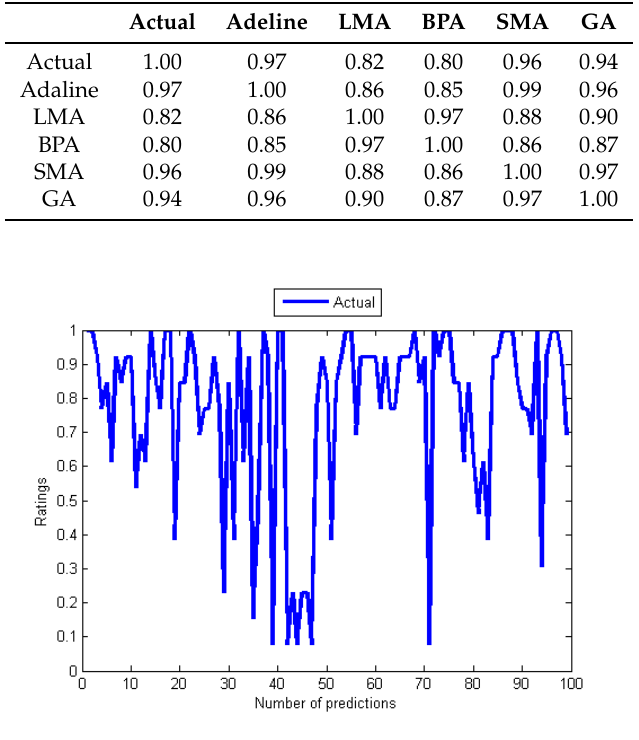
Figure 4. Curve of actual rating from the data